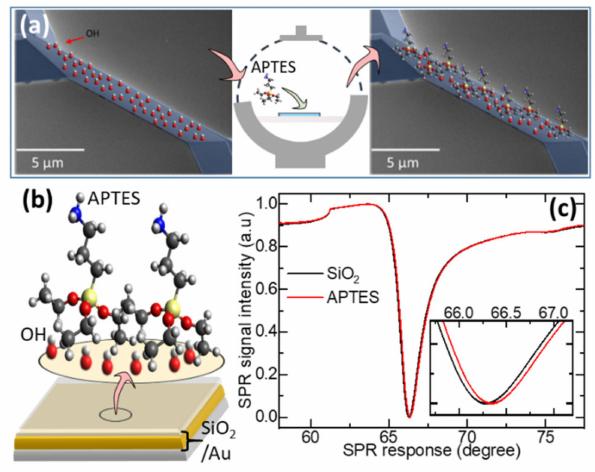
Figure 2. ( a ) Schematic representation of the Fin-FET surface before and after the vapor-phase 3- aminopropyltriethoxysilane (APTES) silanization. ( b ) Schematics illustrating the chemically modified SPR sensor chip with APTES layer. A 10 nm SiO 2 , 50 nm Au SPR layer was used for exploring the APTES functionalization. ( c ) Full SPR reflectance before (in black) and after the APTES silanization process (in red) at λ = 785 nm. The inset shows the shift in SPR angular peak minimum ( Θ SPR